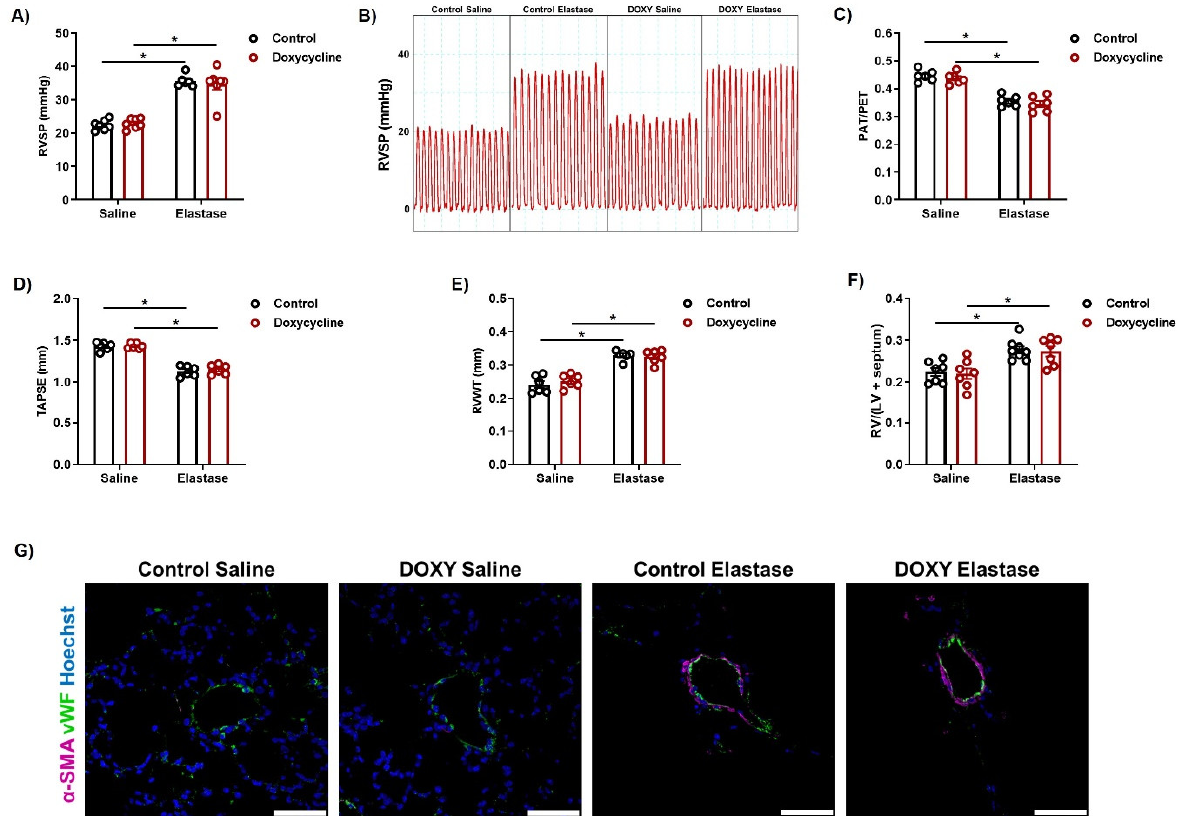
Figure 2. iNOS knockout in AECII cells does not promote reverse remodeling of the pulmonary vasculature upon elastase instillation. Two weeks after intratracheal instillation of saline or elastase, iNos CCSP rtTA2 s -M2 LC1 mice were fed with either standard (control) or doxycycline-containing (Doxycycline, DOXY) chow for additional two weeks. Twelve weeks later, right heart function and structure as well as the vascular structure were investigated. ( A , B ) Right ventricular systolic pressure (RVSP) ( n = 6–7 per group). ( C – E ) Echocardiographic assessment of right ventricular function and dimensions ( n = 6 per group), depicted as ( C ) the ratio (PAT/PET) of pulmonary acceleration time (PAT) and pulmonary ejection time (PET), ( D ) tricuspid annular plane systolic excursion (TAPSE), and ( E ) right ventricular wall thickness (RVWT). ( F ) Changes in right ventricular weight shown as the ratio of the right ventricular (RV) and the left ventricular plus septum (LV + septum) mass ( n = 7–8). LV mass was not significantly altered. Graphs show mean ± SEM. * p < 0.05. Two-way ANOVA (with Tukey’s multiple comparison post-hoc test) was used. ( G ) Representative images of pulmonary vessels in lung sections from control and doxycycline-treated mice instilled either with saline or elastase, co-stained against α -smooth muscle actin ( α -SMA, magenta), von Willebrand factor (vWF, green), and counterstained with Hoechst (blue). Scale bar = 50 µ